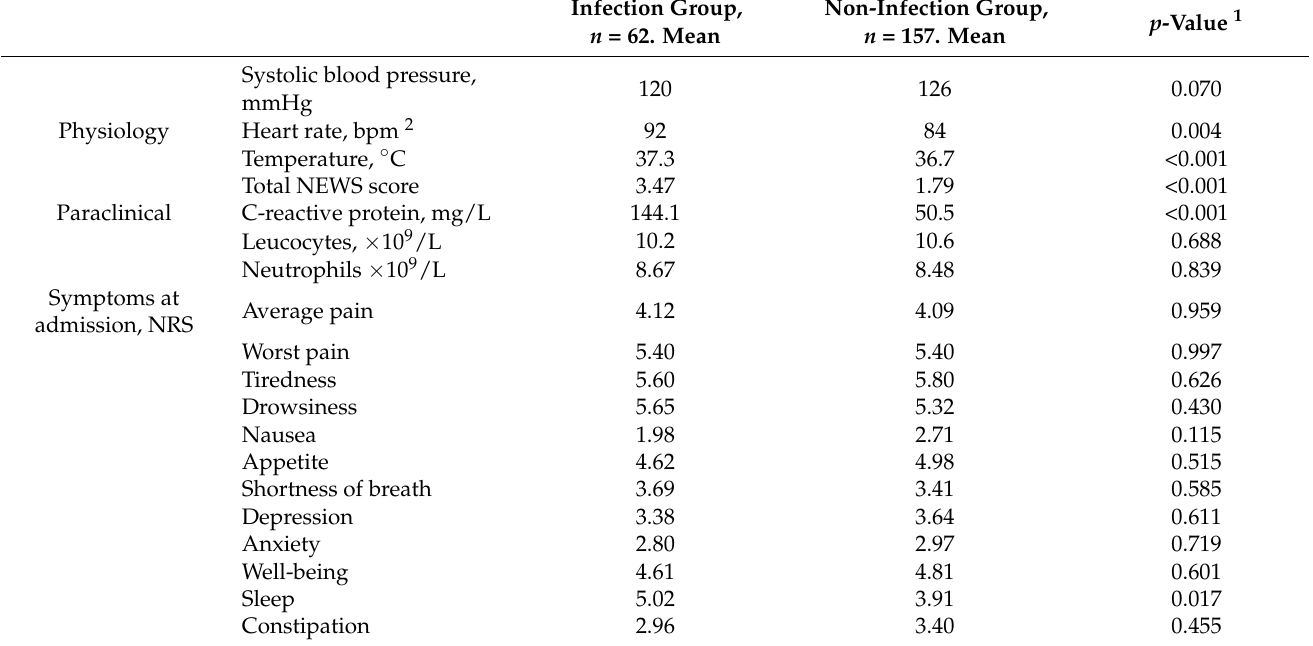
Table 3. Group comparison at admission.